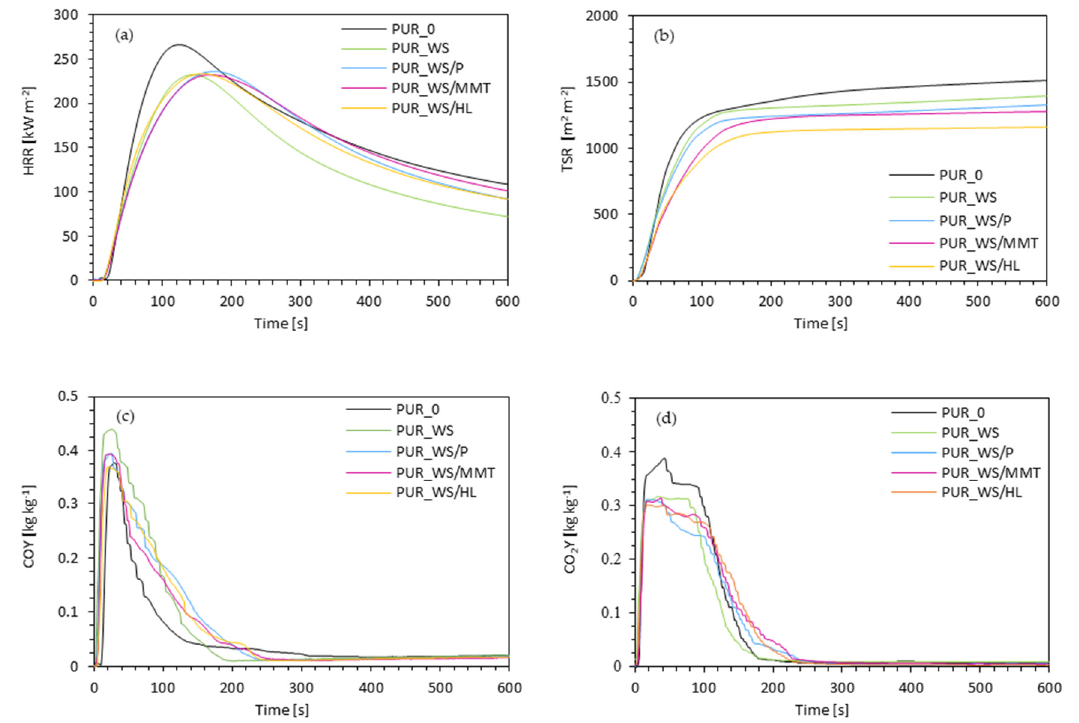
Figure 11. The results of the cone calorimeter experiment—( a ) the peak rate of heat release (pHRR), ( b ) the total smoke release (TSR), ( c ) the average yield of CO, and ( d ) the average yield of CO 2 .